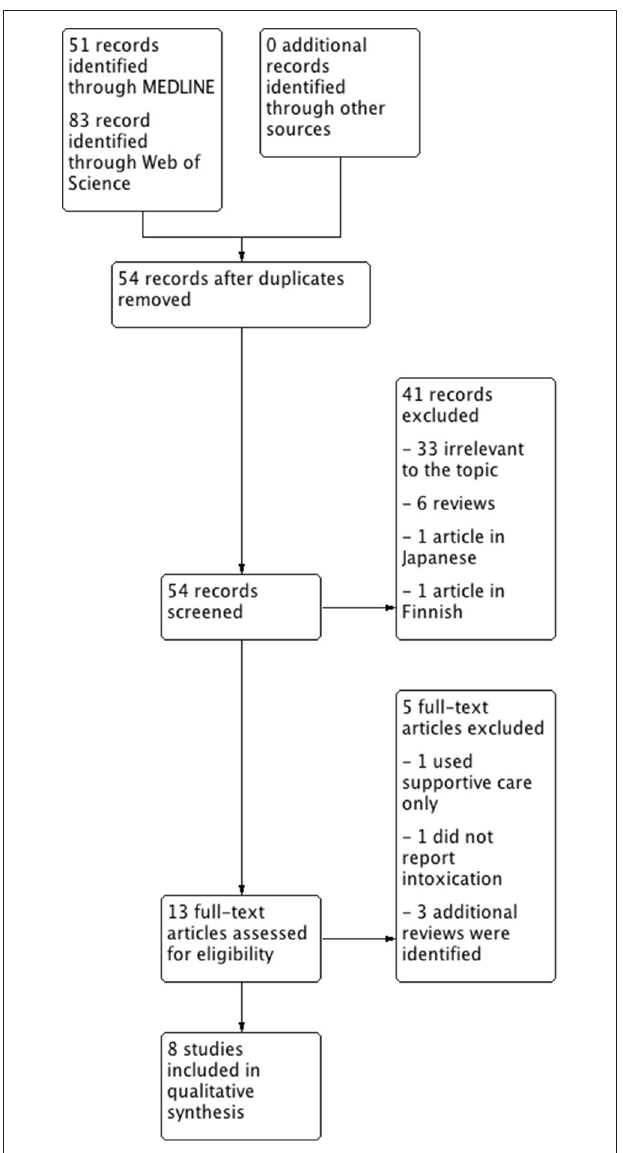
FIGURE 2 | Flowchart of the systematic literature